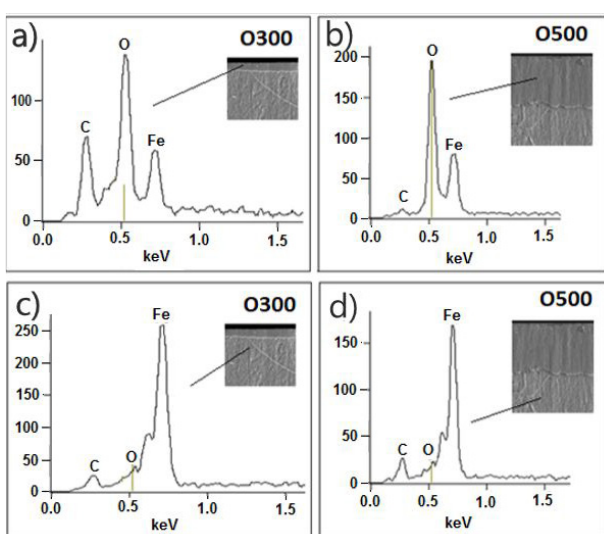
Figure 4. EDS results at different positions next to the surface: oxide layers (a, b); below oxide layers (c,